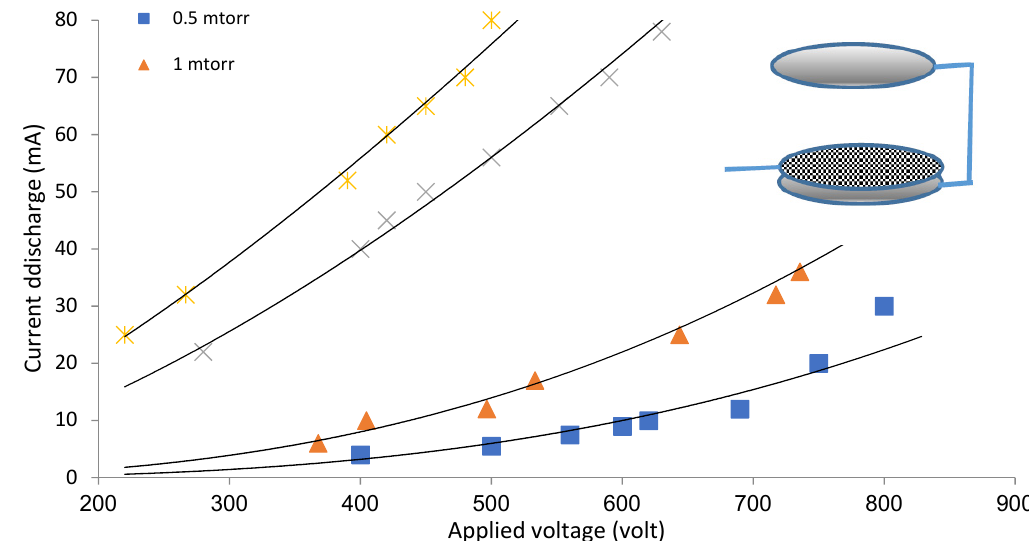
Figure 4. Characteristic I–V curve of argon gas discharge at different pressures and applied voltages, using the OMTSE configuration system.